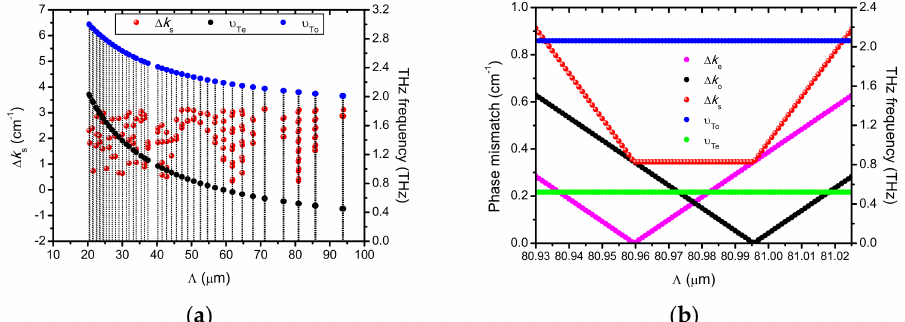
Figure 4. The phase-matching characteristics for the backward SPS processes, λ p = 1550 nm. ( a ) The phase-matching characteristics with Λ from 20 to 100 µ m. ( b ) The detailed phase-matching characteristics with Λ from 80.93 to 81.02 µ